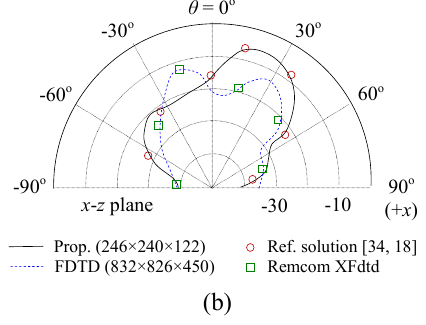
Figure 13: (a) Return loss and (b) radiation pattern of the reconfigurable 120×116 antenna.